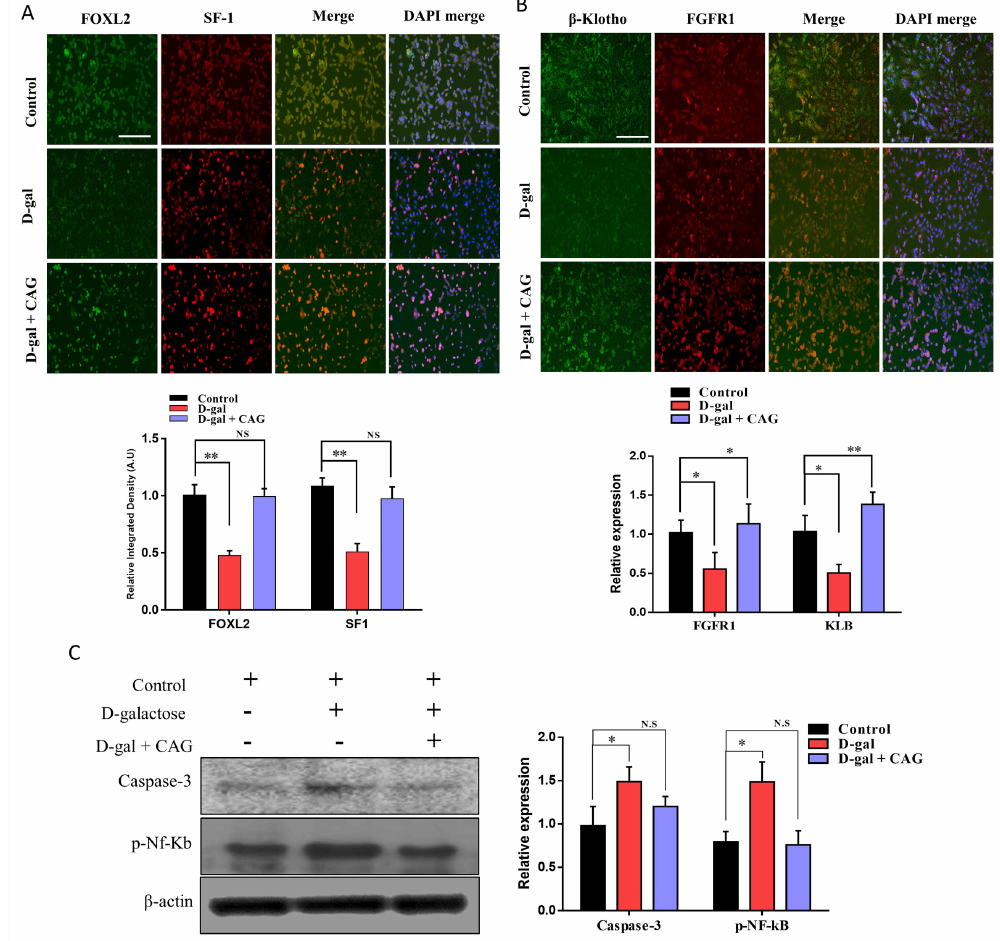
Figure 2. Aging reduces the expression of β -Klotho, and telomerase in cultured cumulus cells. ( A ) Immunofluorescence images of FOXL2 and SF-1 in bovine cultured granulosa cells treated with control, D-galactose, and D-galactose + cycloas- tragenol (the experiment was repeated three times independently and Bar = 100 µ m). ( B ) Immunofluorescence expressions of β -Klotho and FGFR1 show significant ( p > 0.05) reduction with D-galactose treatment (Bar = 100 µ m). ( C ) Western blot expression of Caspase-3 AND NF-Kb in cultured bovine granulosa cells treated with control, D-galactose, and D-galactose + cycloastragenol. The experiment was repeated three times and the data are shown here as a mean ± S.E.M. N.S, not significant, * = p < 0.05, and ** = p <